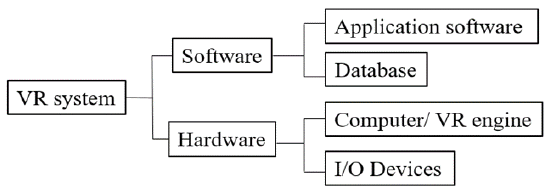
Figure 4. VR software and hardware.